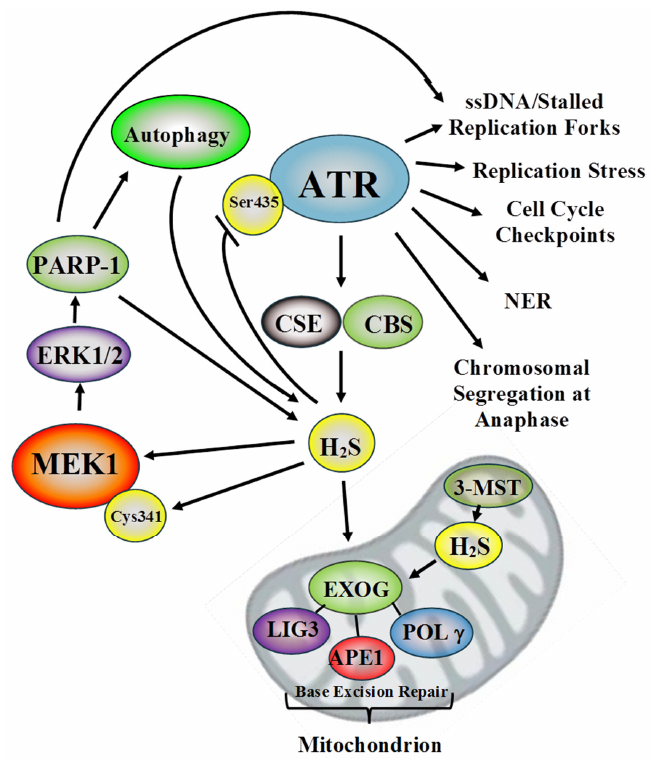
Figure 1. A summary of known pathways by which H 2 S regulates mitochondrial and nuclear DNA repair integrated into one model [11–13,85].